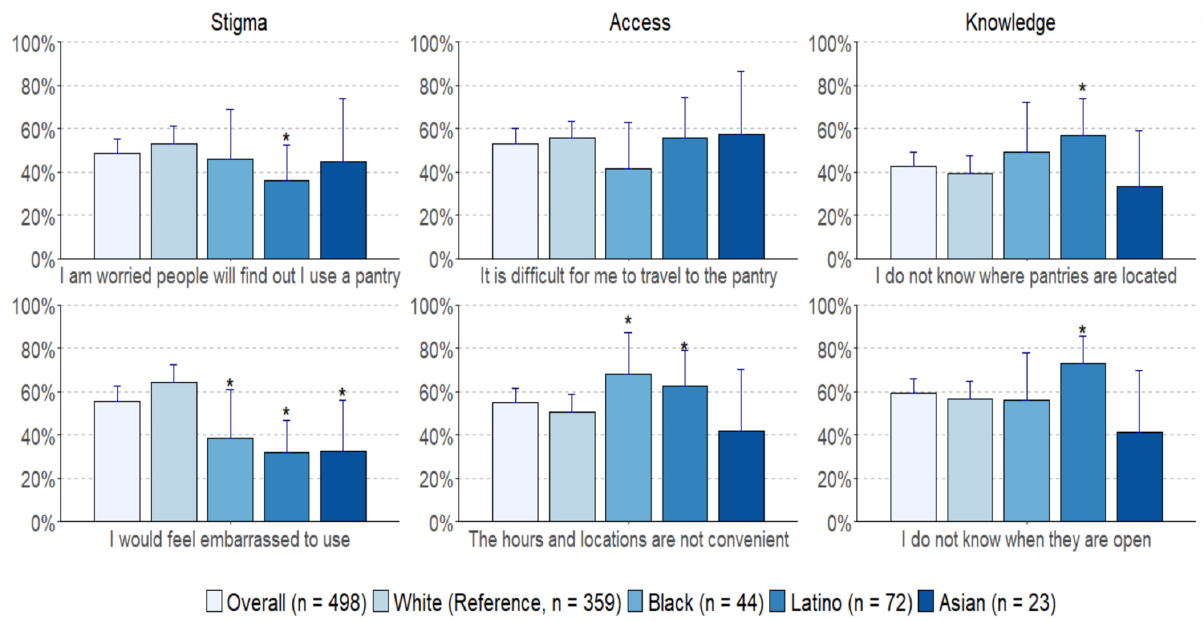
Figure A2. Barriers to food pantry use among food-insecure adults not using pantries during the COVID-19 pandemic. Chi-square tests were performed for each statement for each racial/ethnic group compared to the white reference group; * indicates a p -value < 0.05.